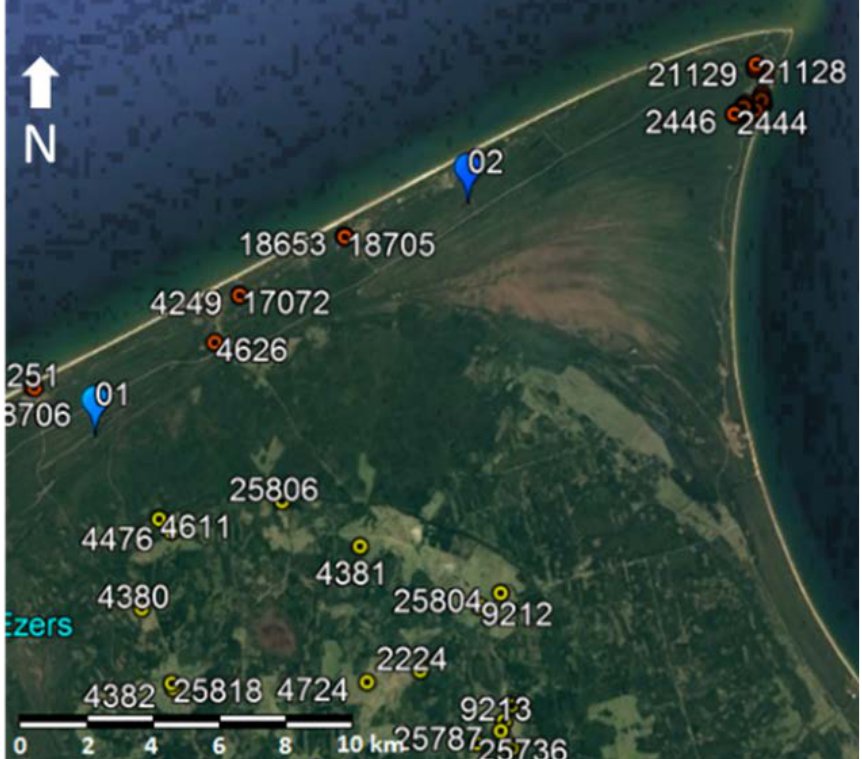
Figure A1. Study area with the location of the wells existing in the LEGMC database: (i) red dots indicate wells drilled near the sea, (ii) yellow dots indicate wells drilled on the cliff of the former Littorina coastline, and (iii) blue dots indicate wells drilled at the Kuksupes and Peterezera inter-dune mires.